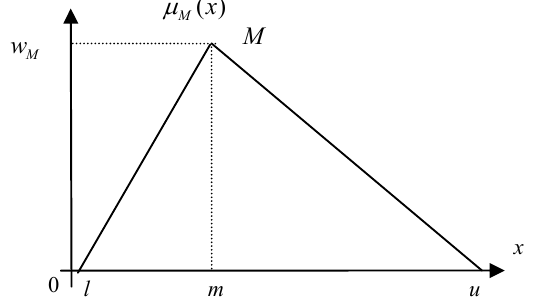
Fig. 1. Geometrical explanation of a generalized triangular l m u w fuzzy number ( , , ; ) M